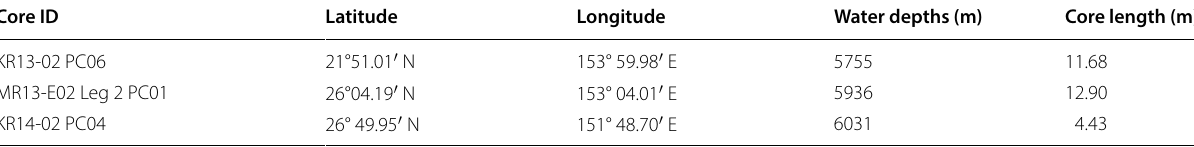
Table 1 Position, water depth, and core lengths of the studied cores in the western North Pacific Ocean Core